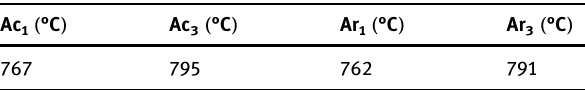
Table 3: Critical transformation temperature of the experimental